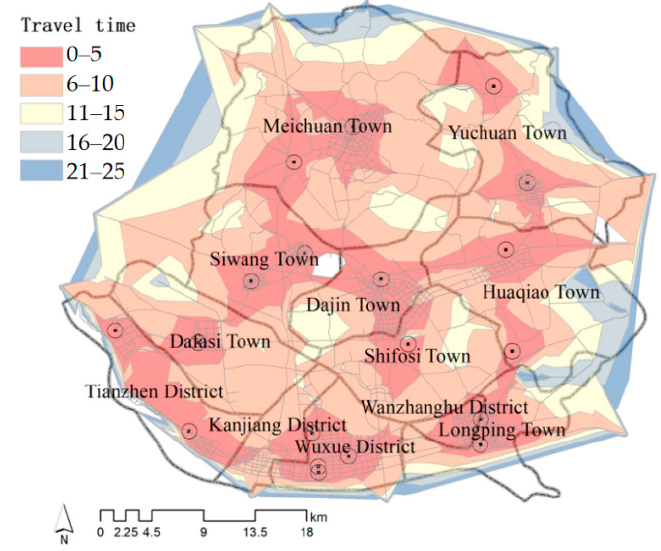
Figure 12. Accessibility analysis of passenger stations.